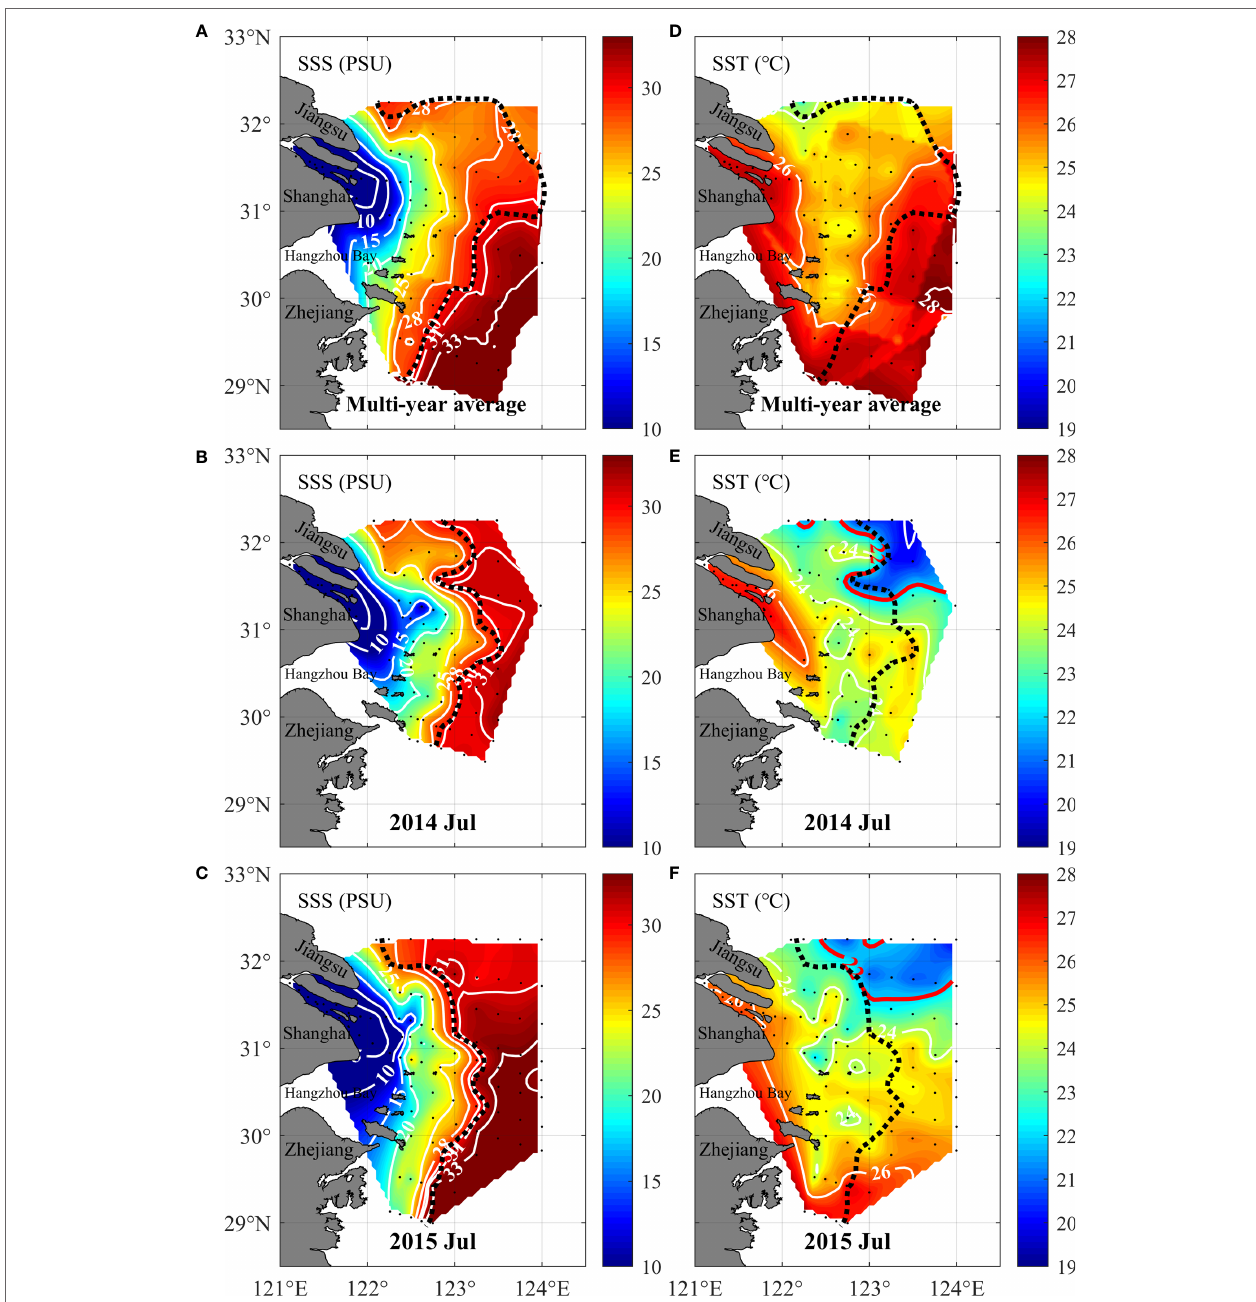
FIGURE 2 | Spatial distributions of the summer sea surface salinity (SSS, A-C ) and sea surface temperature (SST, D-F ) around CRE and its adjacent waters of multi-year average (2013–2018, first row), 2014 (middle row), and 2015 (bottom row). Black dashed lines represent the boundaries of the plume front, and the red solid lines are the isothermal contour of 22°C which represents the boundary of the cold-water zone